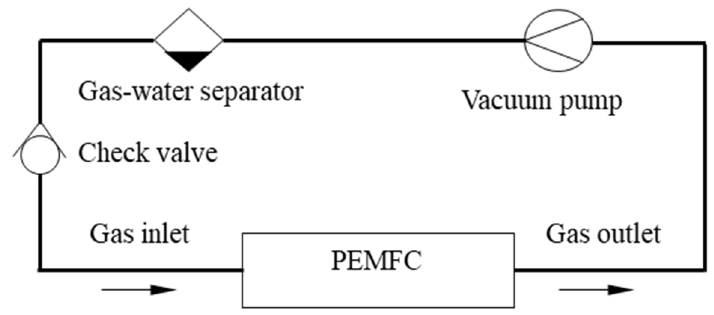
Figure 4. Diagram of the hydrogen cycle module.